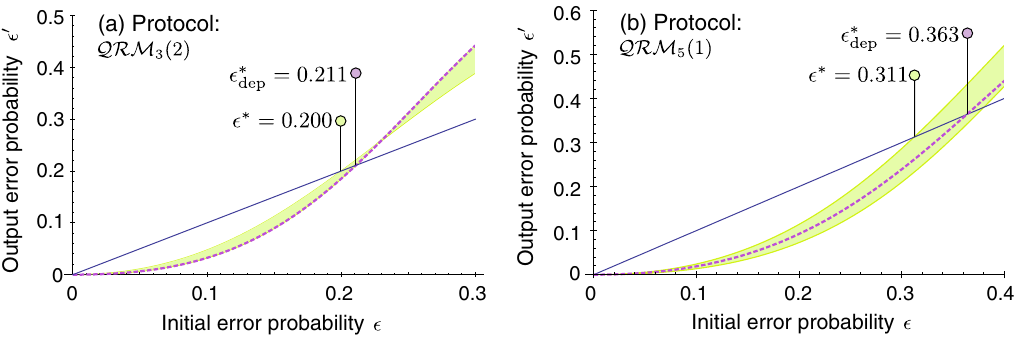
ð 2 Þ and (b) QRM ð 1 Þ . For a fixed (cid:4) , there are many different FIG. 3. The output error (cid:4) 0 against input error (cid:4) for (a) QRM 3 5 compatible states, and so there are many different possible output (cid:4) 0 . These output (cid:4) 0 are shown as a region rather than as a single curve. For the worst-case noise, we mark the threshold (cid:4) (cid:7) . The dashed line shows the specific instance of depolarizing noise, and the is also shown. The straight line is simply the ‘‘breakeven’’ line. associated depolarizing threshold (cid:4) (cid:7) dep